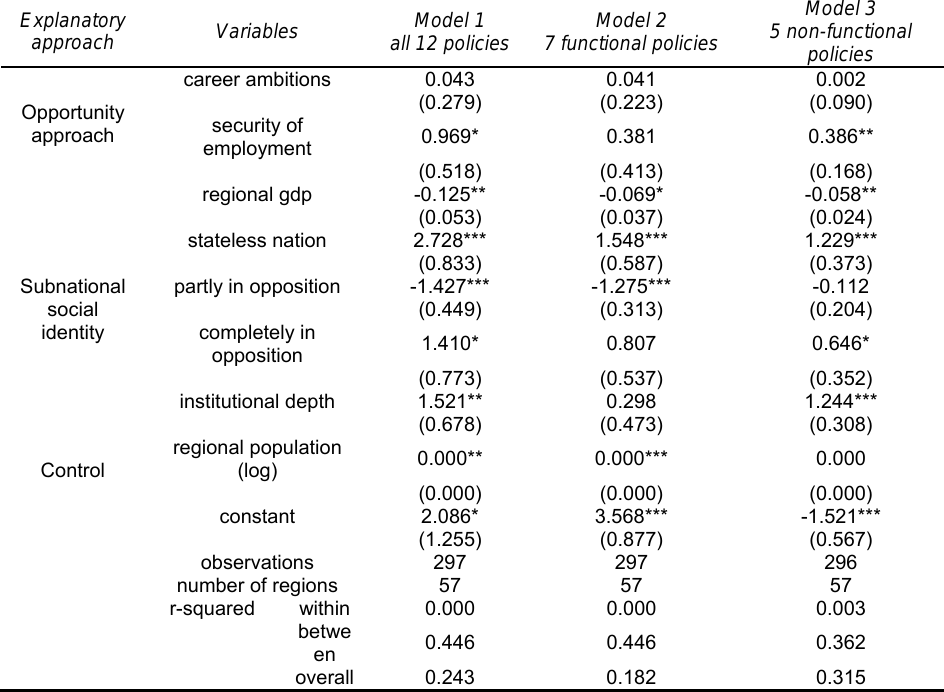
Table 6: Regression results for all 12 policies Explanatory